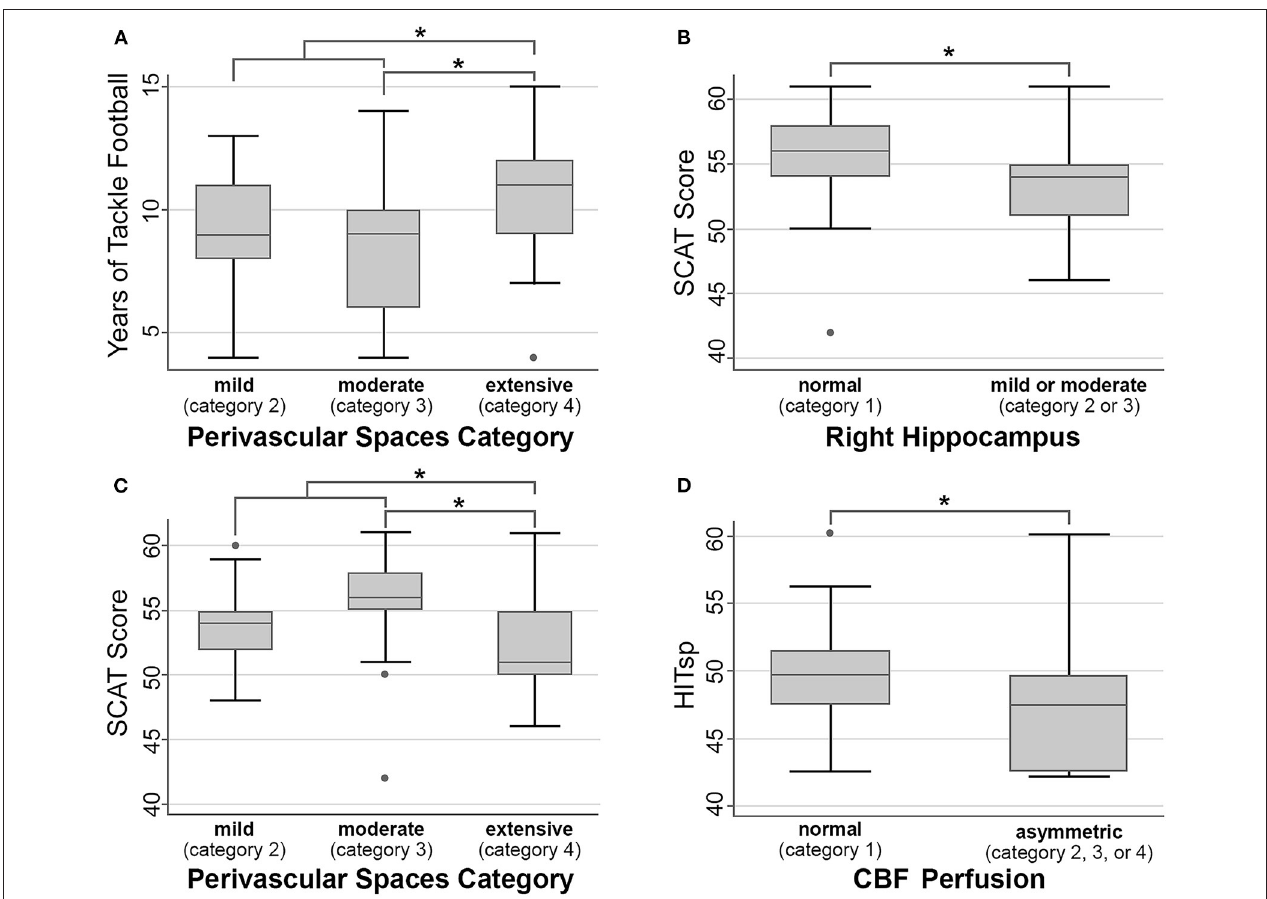
FIGURE 3 | Within-football analyses. Asterisk (*) indicates p < 0.05 uncorrected, but none of these comparisons survive multiple comparison correction, and as such should be considered non-significant trends. (A) Years of tackle football vs. number of perivascular spaces. (B,C) SCAT score vs. right hippocampal size and number of perivascular spaces. (D) HITsp metric of sub-concussive risk and CBF